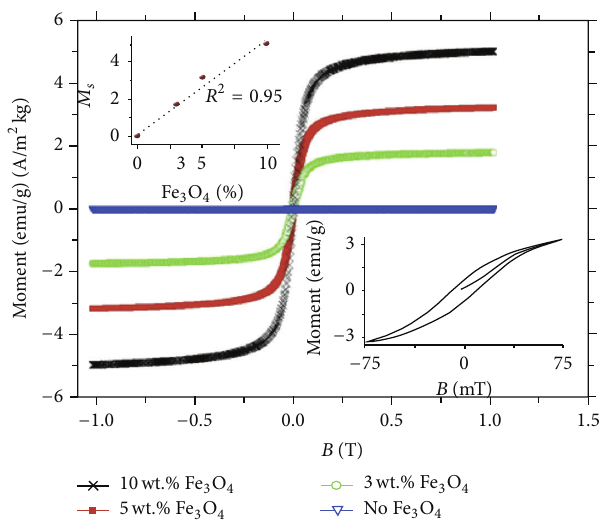
Figure 9: Magnetic saturation versus magnetic field for electrospun PVdF fibre webs with Fe 3 O 4 nanoparticle contents of 0 wt%, 3 wt%, 5 wt%, and